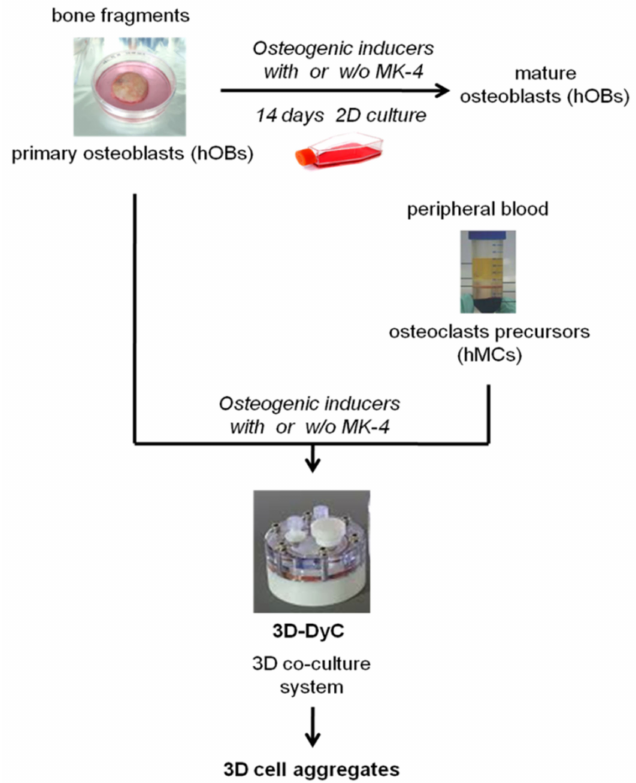
Figure 2. Experimental plan. Bone fragments and peripheral blood samples derived from the same osteoporotic patient were used as sources of osteoblasts (hOBs) and osteoclast precursors (human monocytes, hMCs), respectively. hOBs were treated or not with MK-4 (10 µ M) for 14 days, both in a 2-D conventional culture system (upper part of the scheme) and 3-D co-culture with hMCs producing 3-D bone cells aggregates (lower part of the